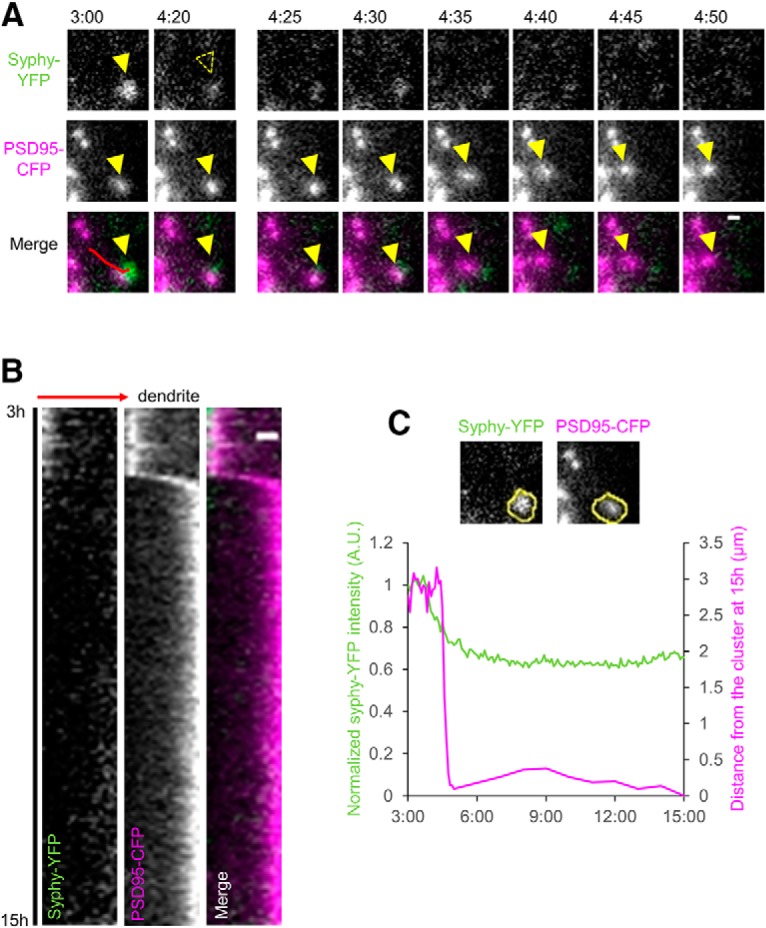
Simultaneous imaging of presynaptic and postsynaptic sites. A, Time-lapse imaging of a PSD-95-CFP cluster moving toward a dendritic shaft after disappearance of a synaptophysin-YFP cluster in contact with the PSD-95-CFP cluster. Merged images (synaptophysin-YFP; green, PSD-95-CFP; magenta) are shown in the bottom row. Yellow arrowheads indicate adjacent synaptophysin-YFP and PSD-95-CFP clusters and elimination of the synaptophysin-YFP cluster at 4 h 20 min and subsequent translocation of the PSD-95-CFP cluster starting at 4 h 30 min after afferent elimination. B, Kymographs created along the red line in the merged image at 3 h in A. Each column of the kymographs shows synaptophysin-YFP, PSD-95-CFP, and their merged images (synaptophysin-YFP; green, PSD-95-CFP; magenta) from left to right, respectively. The kymographs start and end at 3 and 15 h after afferent elimination. The direction toward the dendritic shaft is indicated by a red arrow. C, Images of a synaptophysin-YFP cluster and a PSD-95-CFP cluster at 3 h after afferent elimination with yellow ROIs set to quantitate fluorescent intensities of the synaptophysin-YFP cluster (green line in the graph) and translocation distance of the PSD-95-CFP cluster measured from the final position at 15 h after cutting (magenta line in the graph). Error bars are SEM. Scale bars = 1 μm.